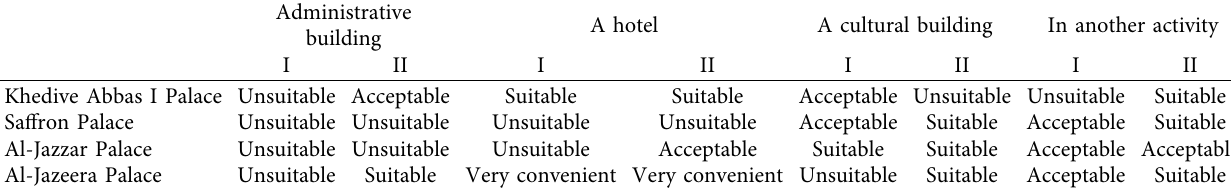
Table 18: Evaluation for each building activity.